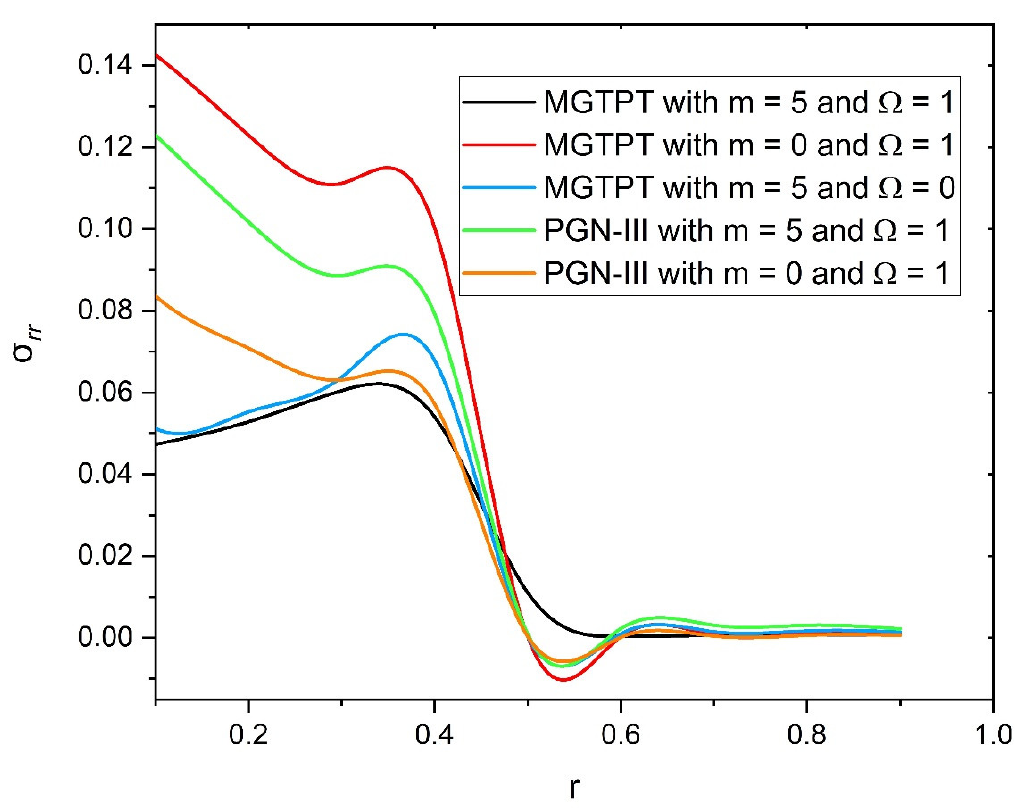
Figure 5. The deviation in radial stress for various models with Hall effect and rotation.